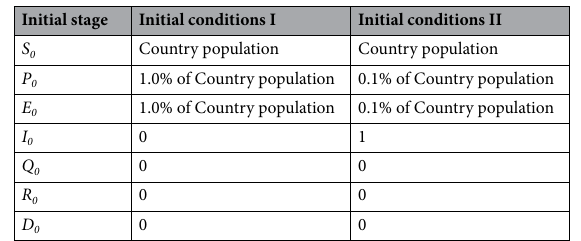
Table 1. Two sets of initial conditions. Initial conditions I imply that the infection is triggered via the higher E 0 percentage, hence I 0 = 0. Initial conditions II imply that the infection is already triggered. i.e., I 0 = 1 with lower E 0 percentage.